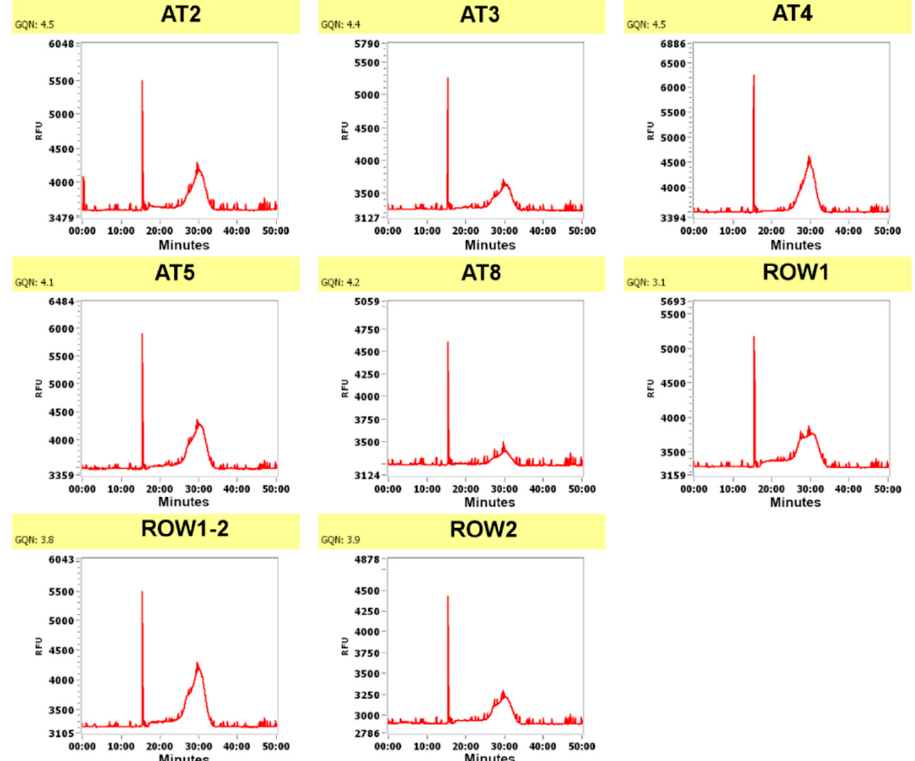
Figure 1. DNA fragment analyzer results for the samples using the PROSize v. 2.0 software. RFU signifies Relative Fluorescence Units (indicating the amount of DNA at a certain size/time), and the X-axis signifies time in minutes as the DNA fragments are separated during capillary electrophoresis.